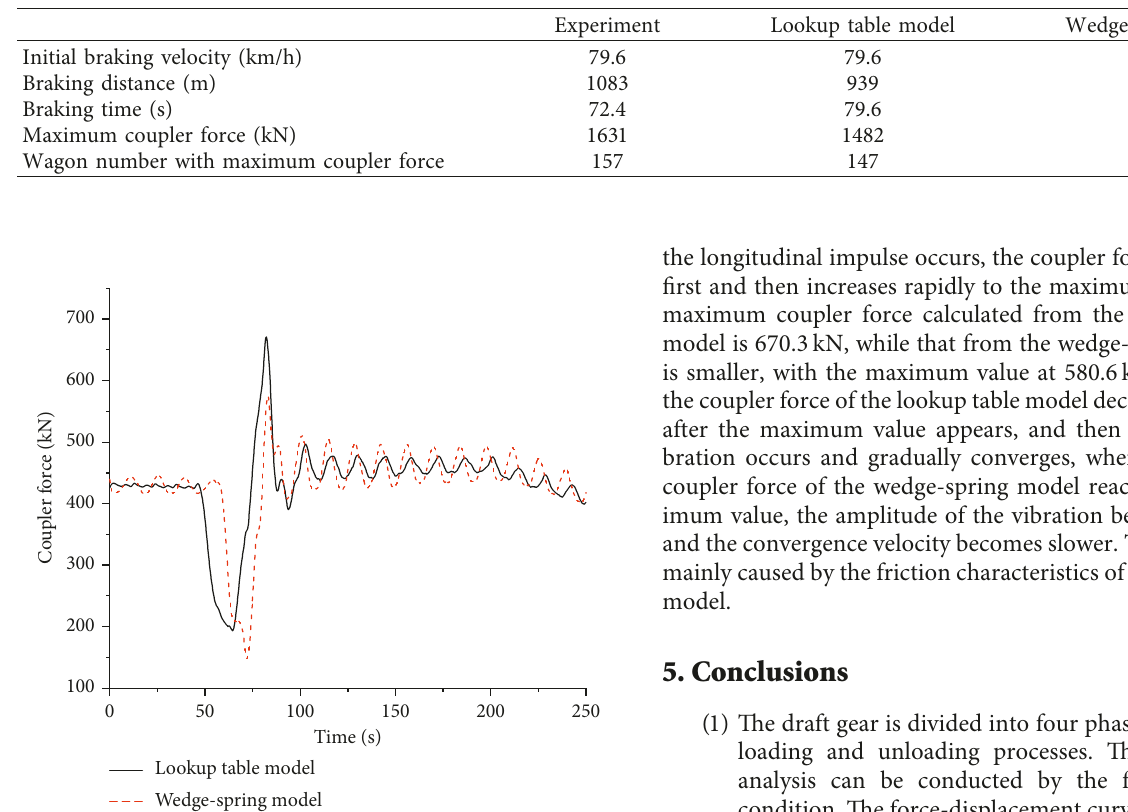
Table 3: 170kPa applied full-braking experiment and simulation results.